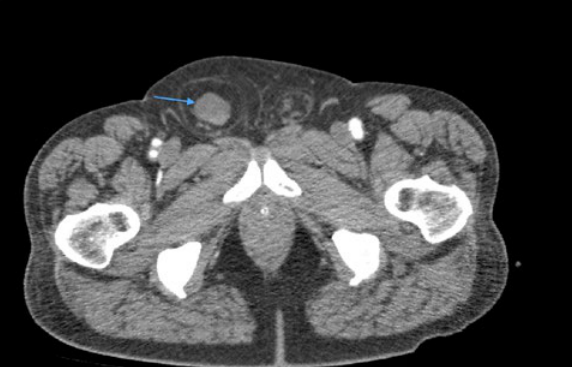
Figure 1b: Axial CT showing indirect inguinal hernia (blue